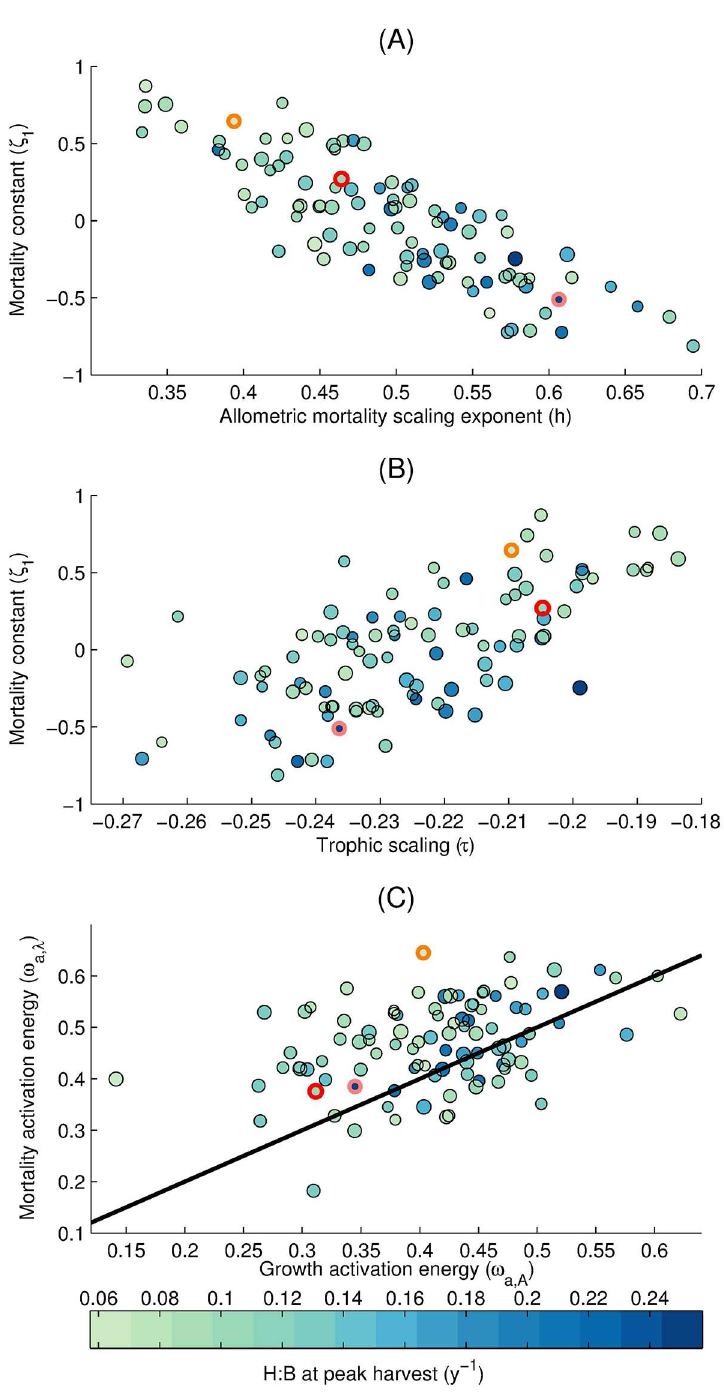
Fig 9. Harvestto biomass ratio (H:B) at peak harvest in terms of three sets of parameter combinations. Circles are members of the optimizedset of model parameters. Circle color represents the H: H sim B ( y − 1 ) calculatedas the total harvest ( ) over the total biomass at the year of globalpeak harvest i Globalmax integratedover the LMEs, while the circle size is proportional to the peak harvest. Horizontaland vertical axes correspond to parameter values from the Monte Carlo suite. Thick orange, red, and peach circles correspond to the low, medium, and highH:B members that are used in Fig 10. The black line in (C) is the identity line (1:1